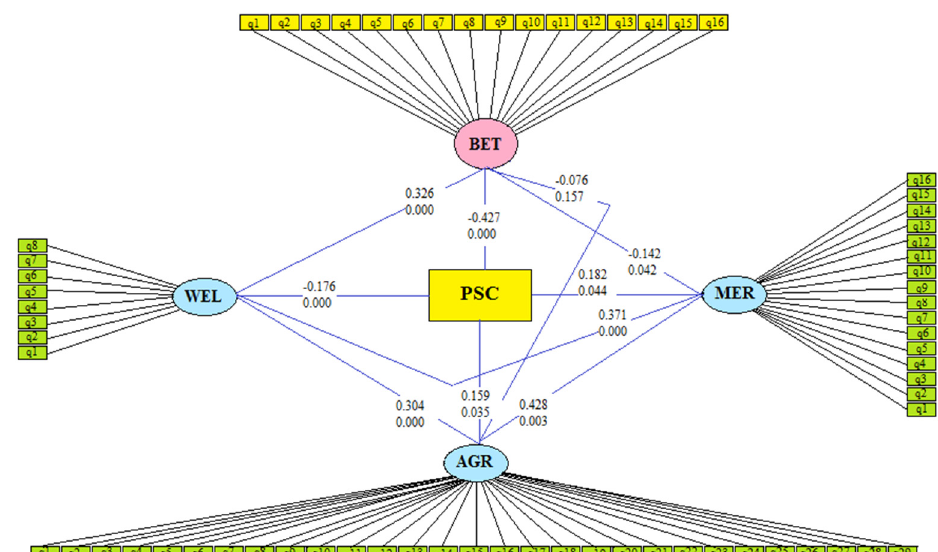
Figure 2. The effect of explicit and implicit variables of Iraqi data. Table 10. Regression results of Iranian